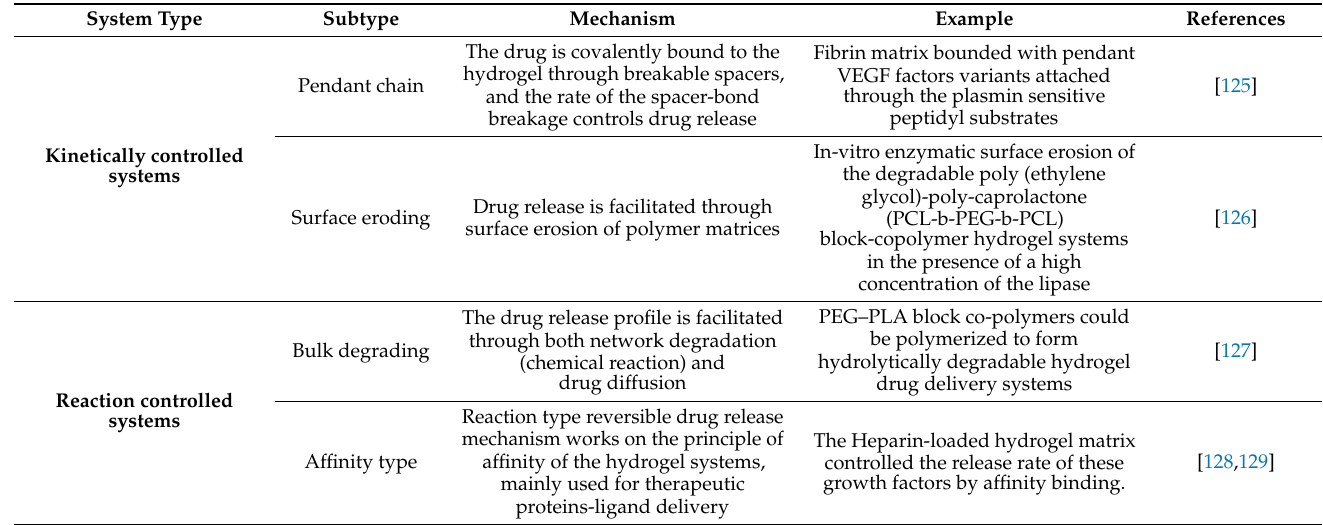
Table 2. The kinetic and reaction controlled hydrogel, their subtypes and drug release